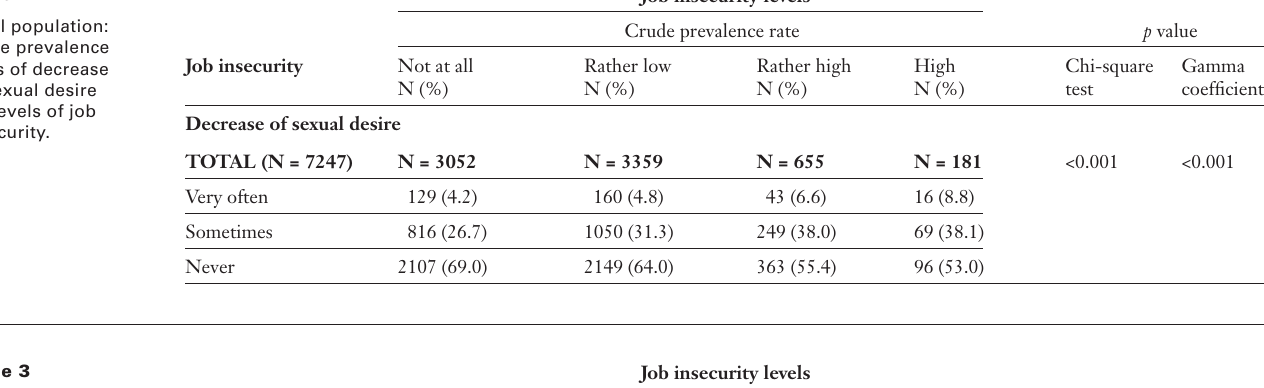
Men: crude prevalence rates of decrease in sexual desire for levels of job insecurity.